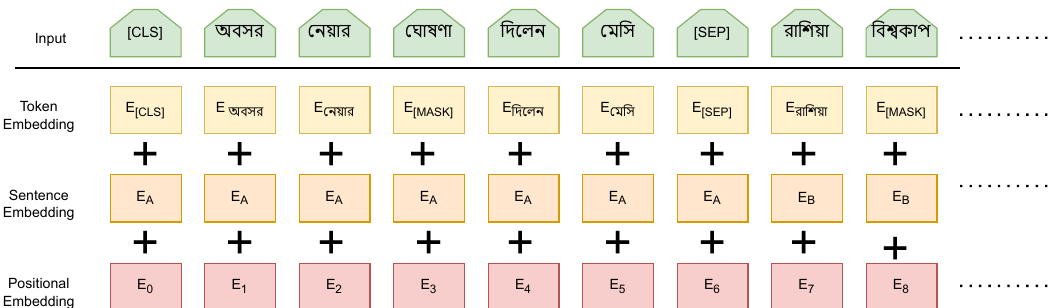
Figure 5. The word embedding of our input corpus with BERT